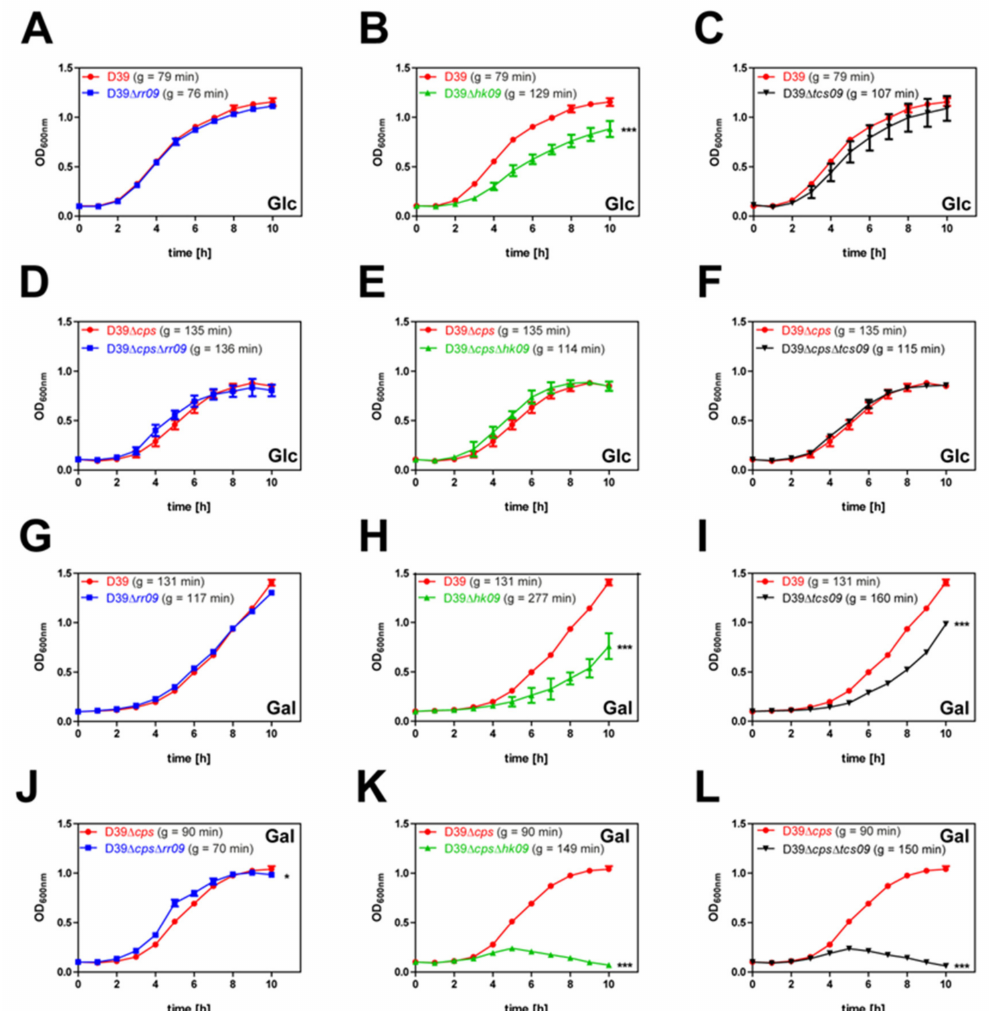
Figure 1. Growth kinetics of RR09-, HK09-, and TCS09-deficient D39 pneumococci and parental strains under defined nutrient resources. The parental strains D39 or D39 ∆ cps and their isogenic ∆ rr09 -, ∆ hk09 -, and ∆ tcs09 -mutants were culti- vated in a chemically-defined medium (CDM) with glucose or galactose as a carbon source at 37 ◦ C under microaerophilic conditions. ( A – F ) Growth behavior with glucose as a carbon source. ( G – L ) Growth kinetics with galactose as the sole carbon source. Results are presented as the mean ± SD for three independent experiments. The mean value of the generation time of the respective strain is given in brackets. A two-way ANOVA proved a significance with p -value * < 0.05 and *** < 0.001 relative to the parental pneumococcal strain. g: generation